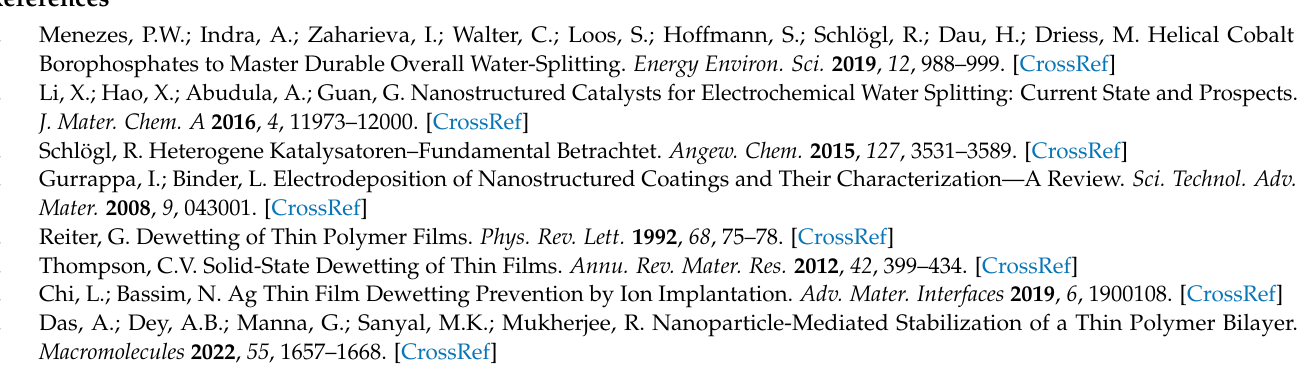
microscrolls; Figure S3: Comparison of film cross-sections in the absence and presence of PSS; Figure S4: Small-angle X-ray scattering patterns for non-scrolled Co(OH) 2 films and Co(OH) 2 /PSS microscrolls; Figure S5: X-ray diffractograms of Co(OH) 2 microscrolls prior to and after thermal treatment; Figure S6: Representative Raman spectrum of a selected Co(OH) 2 microscroll; Figure S7: Confocal Raman microscopy line scan along the cross-section of an individual Co(OH) 2 /PSS mi- croscroll; Figure S8: Comparison of OER performance of additive-free Co(OH) 2 films as deposited and after pseudomorphic conversion to Co 3 O 4 films; Figure S9: Overview of the deposition of Co(OH) 2 /poly(allylamine hydrochloride) hybrid materials; Figure S10: Dynamic light scattering data of aqueous PSS solutions with increasing additions of Co 2+